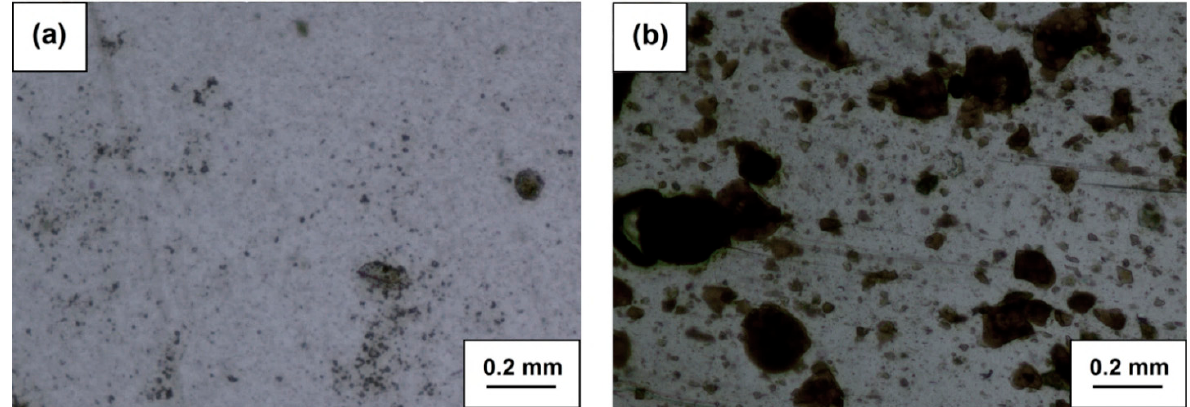
Figure 10. Optical microscopy images of PVC/silica ( a ) and PVC/lignin ( b ) composites with filler content in both materials equal to 7.5 wt %.